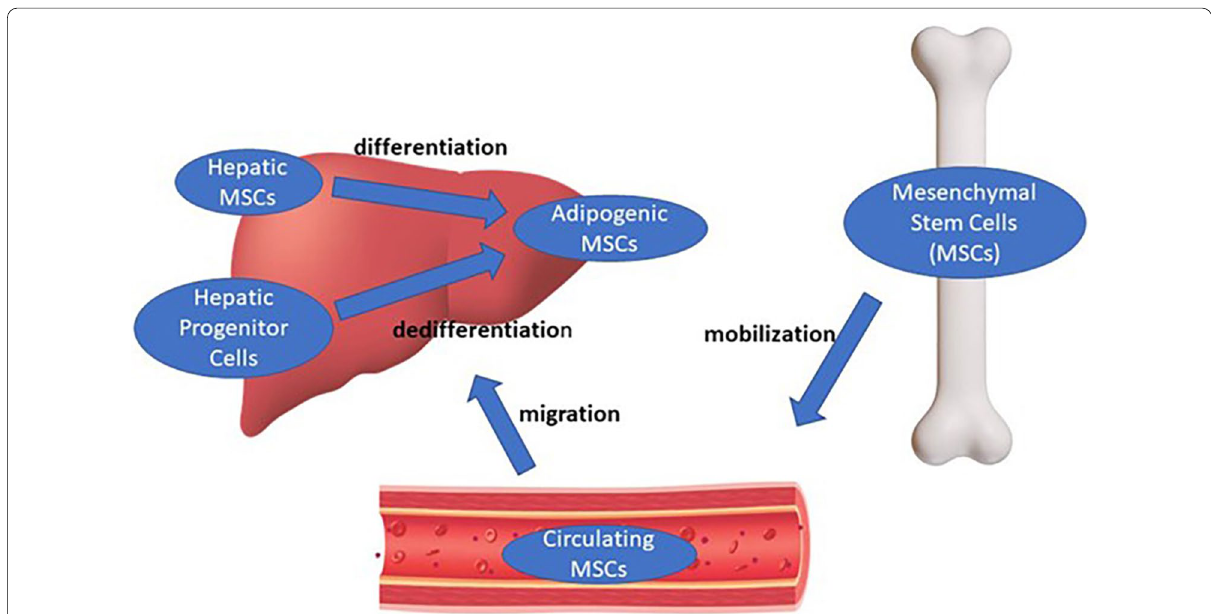
Fig. 4 Potential source of adipocytic cells in primary hepatic liposarcoma. Hepatic mesenchymal stem cells (MSCs), circulating MSCs, and hepatic progenitor cells (HPCs) are potential origins. Hepatic MSCs serve as potential cells of origin for primary hepatic liposarcoma due to their multipotency. Stimulation or damage to the liver can trigger circulating MSC migration, and abnormal adipocytic differentiation may form hepatic liposarcoma. HPCs result from hepatocytes that dedifferentiate and undergo epithelial–mesenchymal transition to mesenchymal-like stem cells, which, in turn, form the basis of liposarcoma